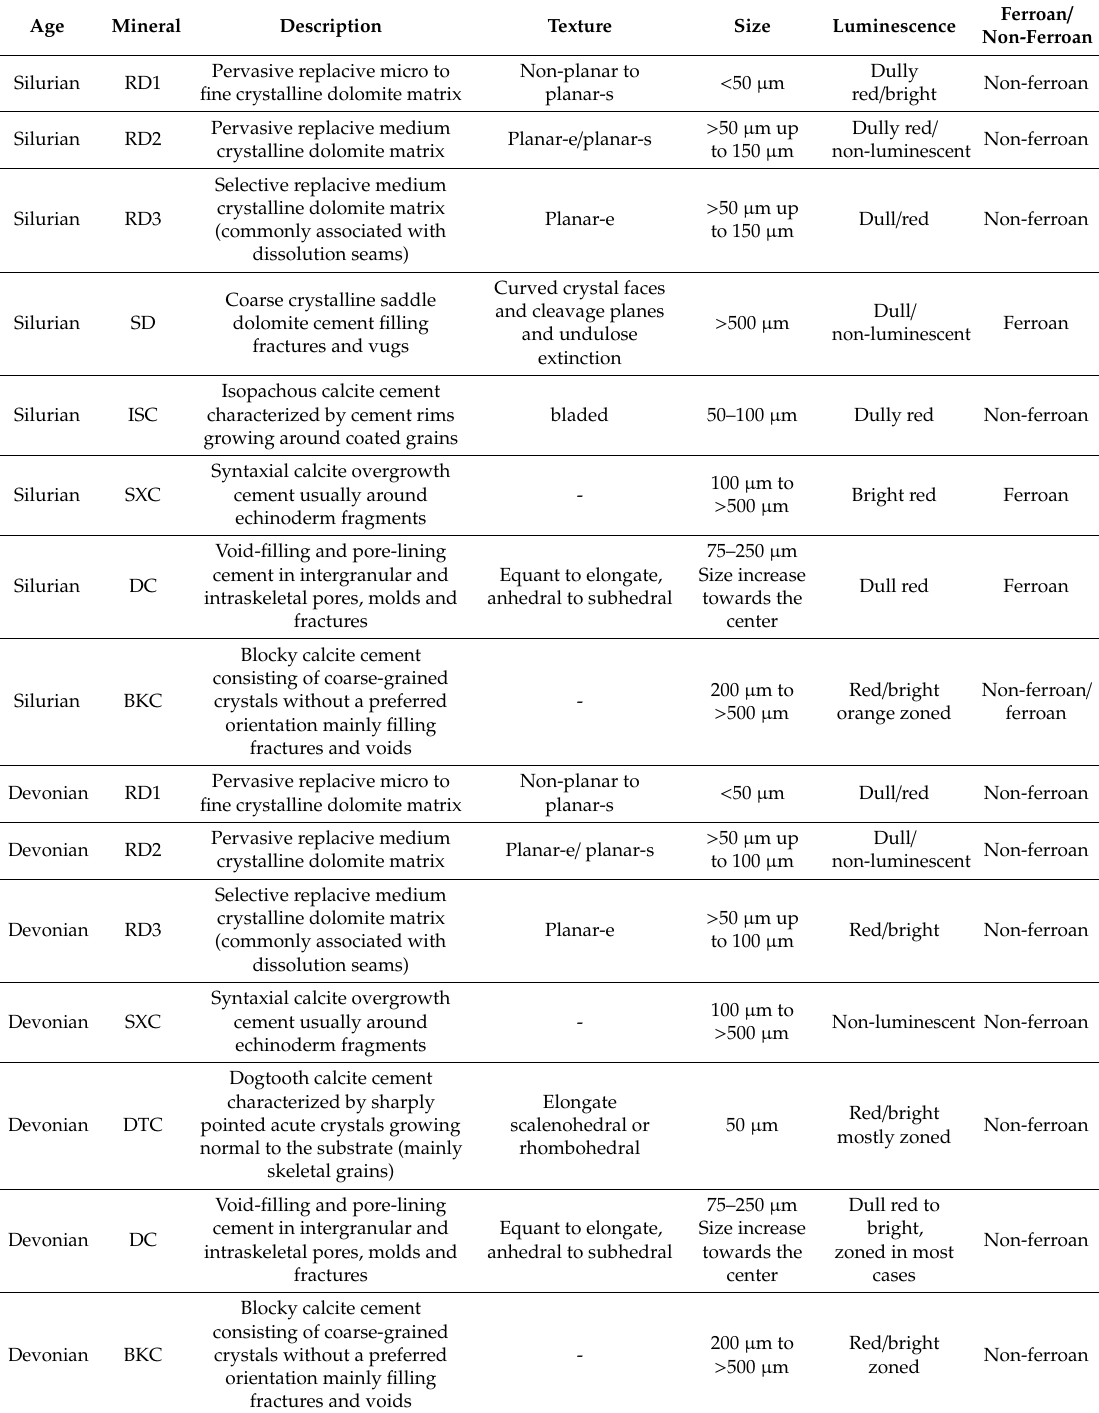
Table 2. Summary of the main petrographic characteristics of the carbonate minerals observed in Silurian and Devonian